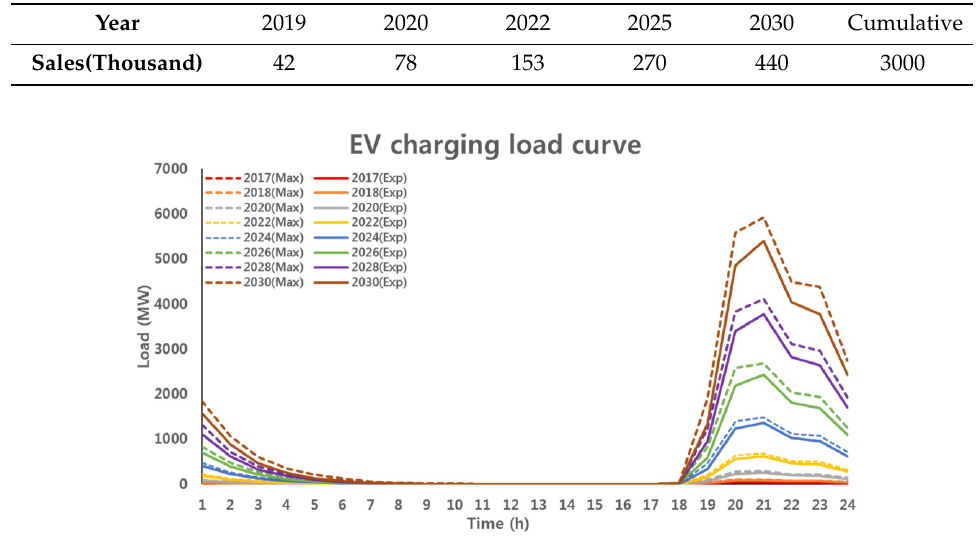
Table 19. The annual sales target of EVs.